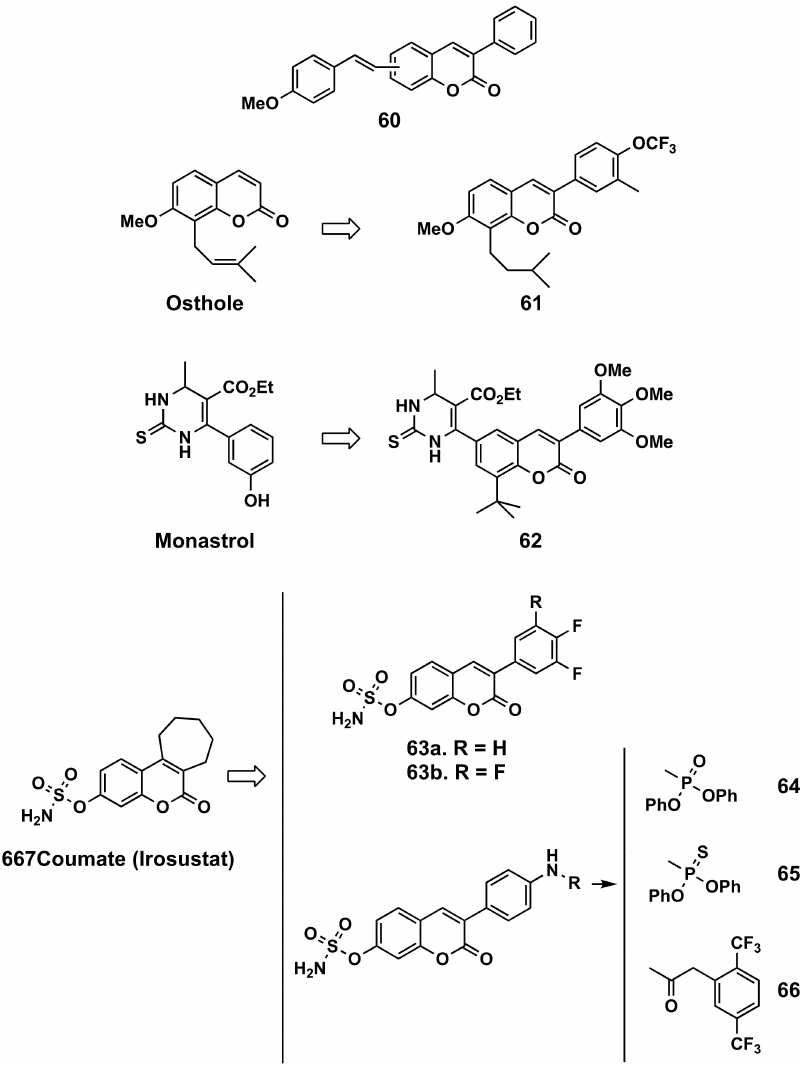
Figure 21. 3-Phenylcoumarins as anticancer agents: coumarin hybrids or inspired by other already known